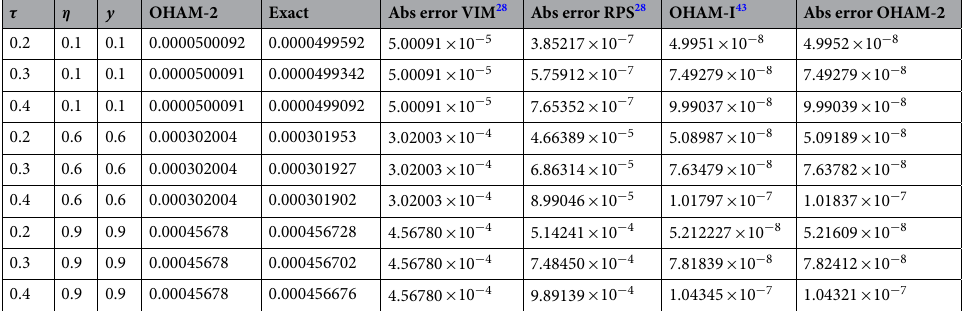
Table 3. Comparison of absolute errors obtained by the OHAM-2 and PIA and RPS methods when α = 1.0 and (cid:31) = 0.001 for FZK(3,3,3).